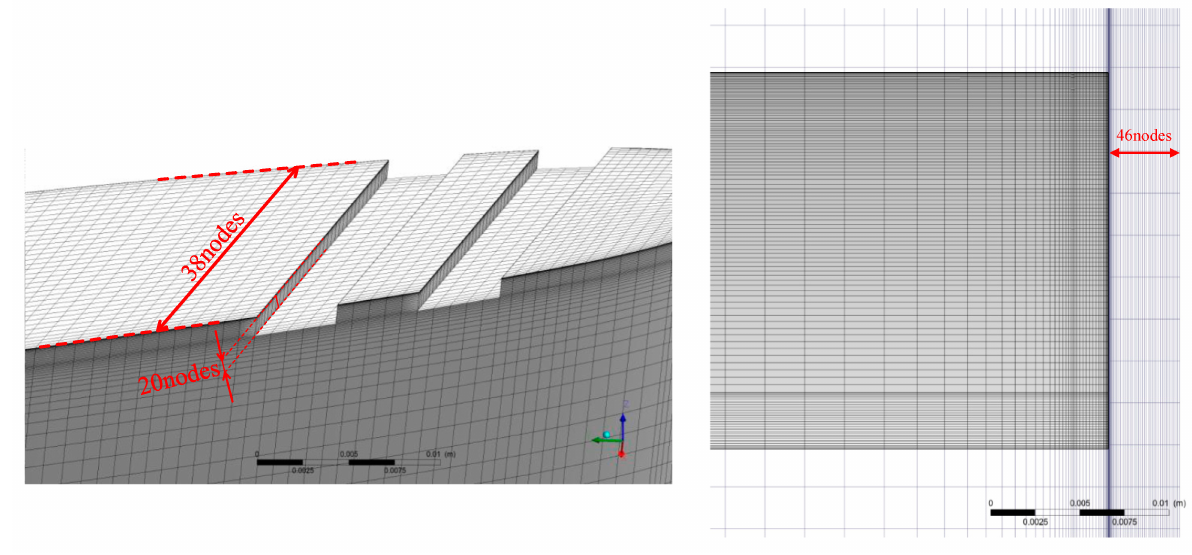
Figure 3. Mesh arrangement of hydrofoil.